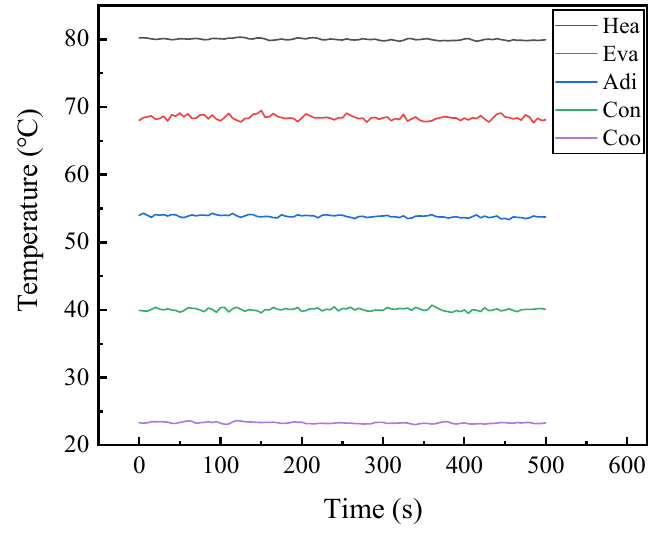
Figure 7. The internal temperature change of FR40% at 80 °C.